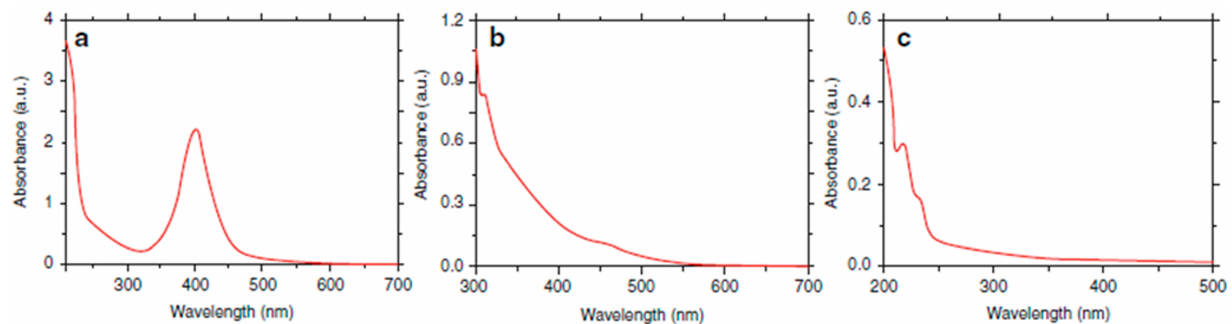
Figure 4. Absorption spectrum for ( a ) silver NPs with an SPR located at λ SPR (Ag) = 400 (nm), and the corresponding absorption for ( b ) medium and ( c ) small silver clusters, displaying an semiconductor (SC) and molecular/SC-like absorption behavior, respectively; taken from